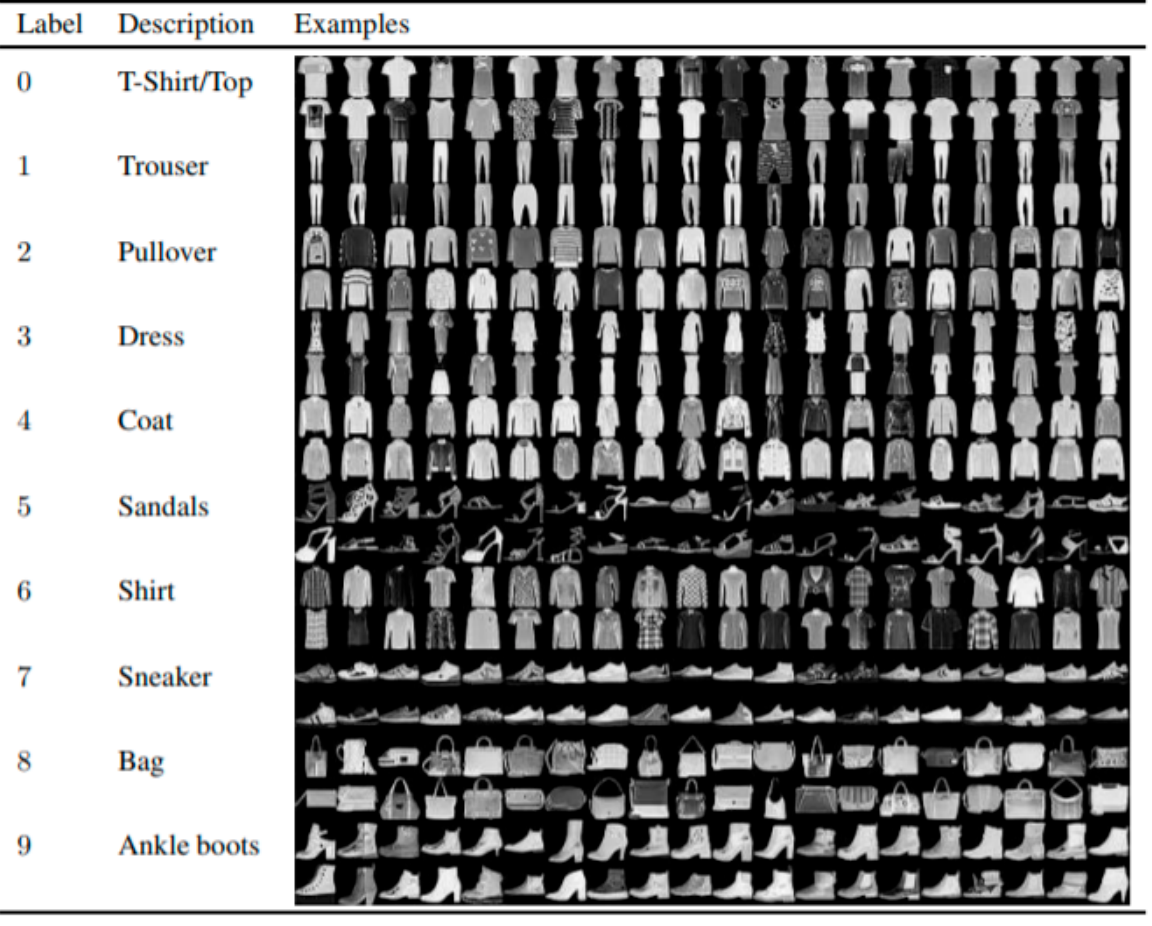
Table 2. Google search phrases for each class for the collection of the datasets.